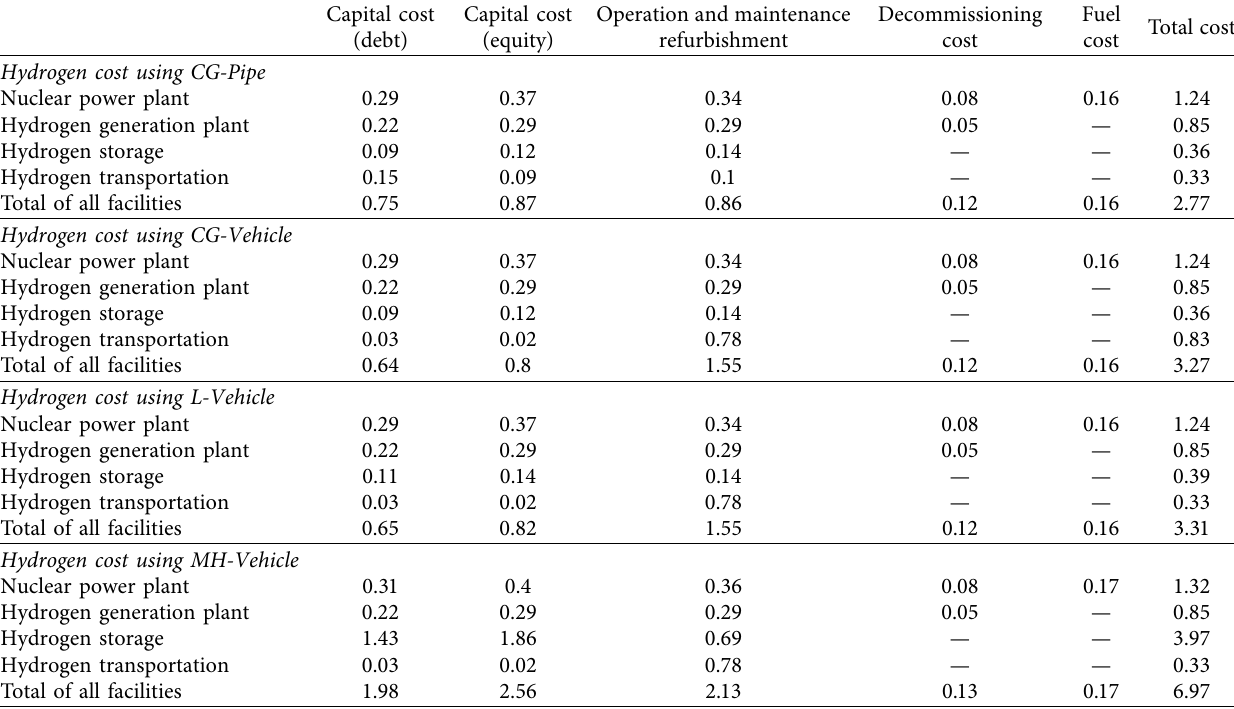
Table 3: Hydrogen production cost using SMART